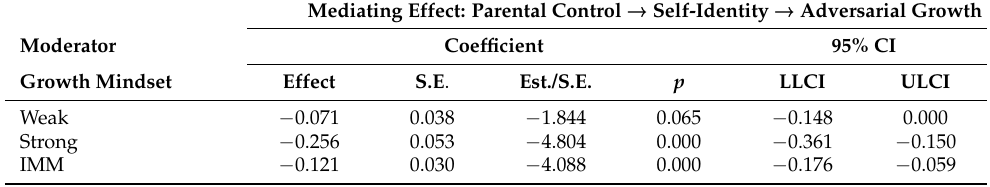
Table 6. Moderated mediation effect ( N =